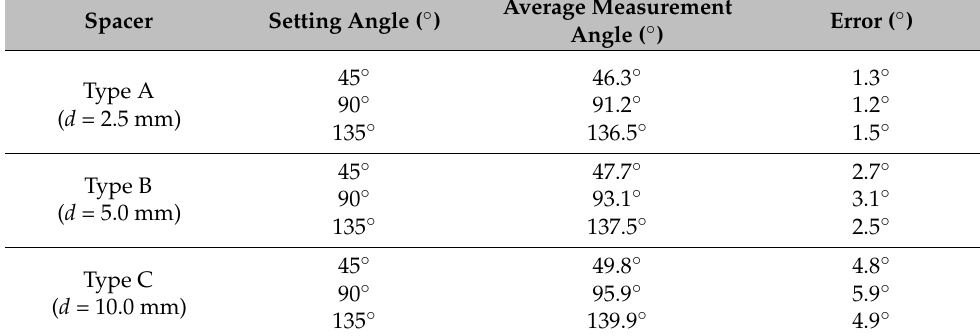
Table 3. Comparison table for the phantom test with different types of spacers.